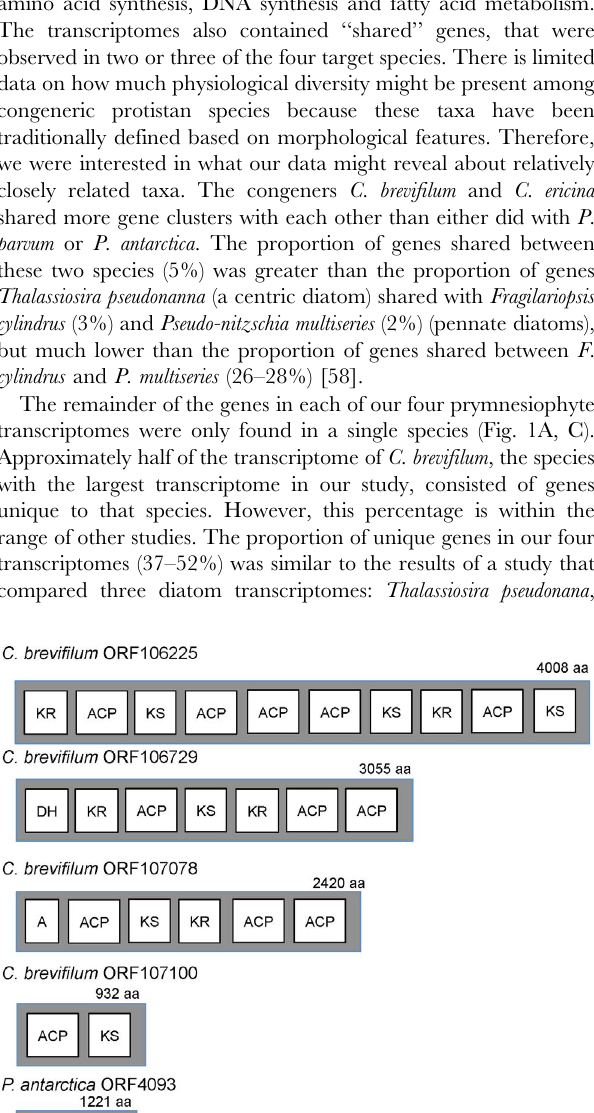
Figure 2. Polyketide synthase maximum likelihood tree with 100 iterated bootstraps using only the keto-synthase (KS) domain. The tree was inferred using MEGA5 (Tamura et al. 2011) with maximum likelihood method based on Jones-Taylor-Thornton model. The analysis involved 78 amino acid sequences. All positions with less than 95% site coverage were eliminated. There were 181 total sites in the final dataset. Bootstrap support values, if greater than 50%, are shown as the percentages of 100 trees inferred in the analysis. The scale bar represents the number of substitutions per site. The tree is rooted with Aspergillus nidulans polyketide synthase. Sequences from our dataset are shown in bold. Multiple branches have the same identifying ORFs,GI or accession numbers due to multiple KS domains on the same gene.